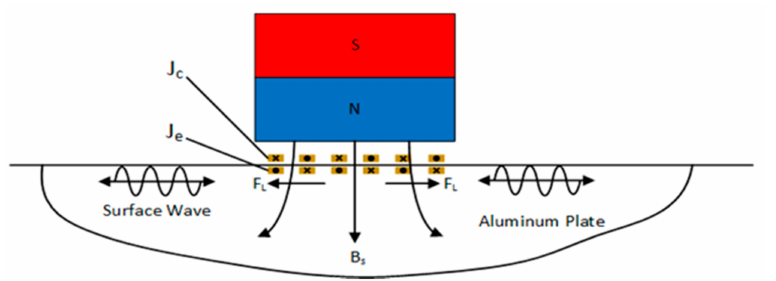
Figure 1. Schematic diagram of the ultrasonic generation mechanism of a meander-line-coil surface wave EMAT based on the Lorentz